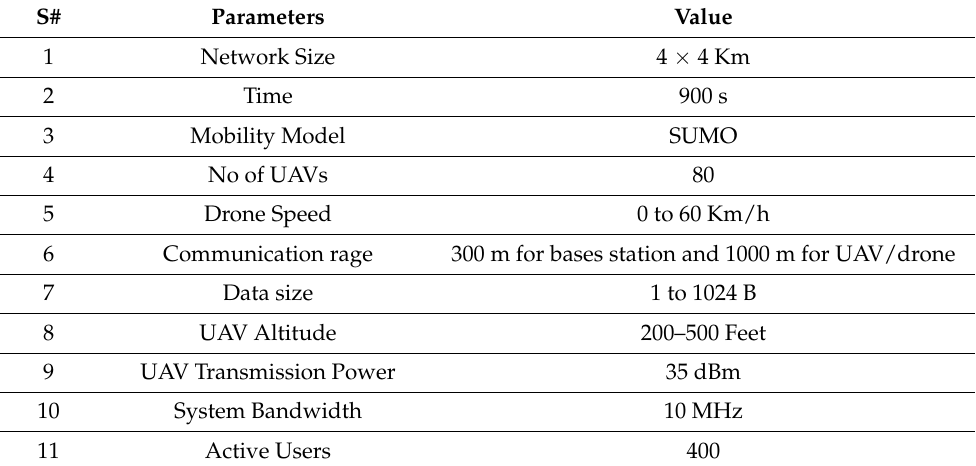
Table 2. Simulation